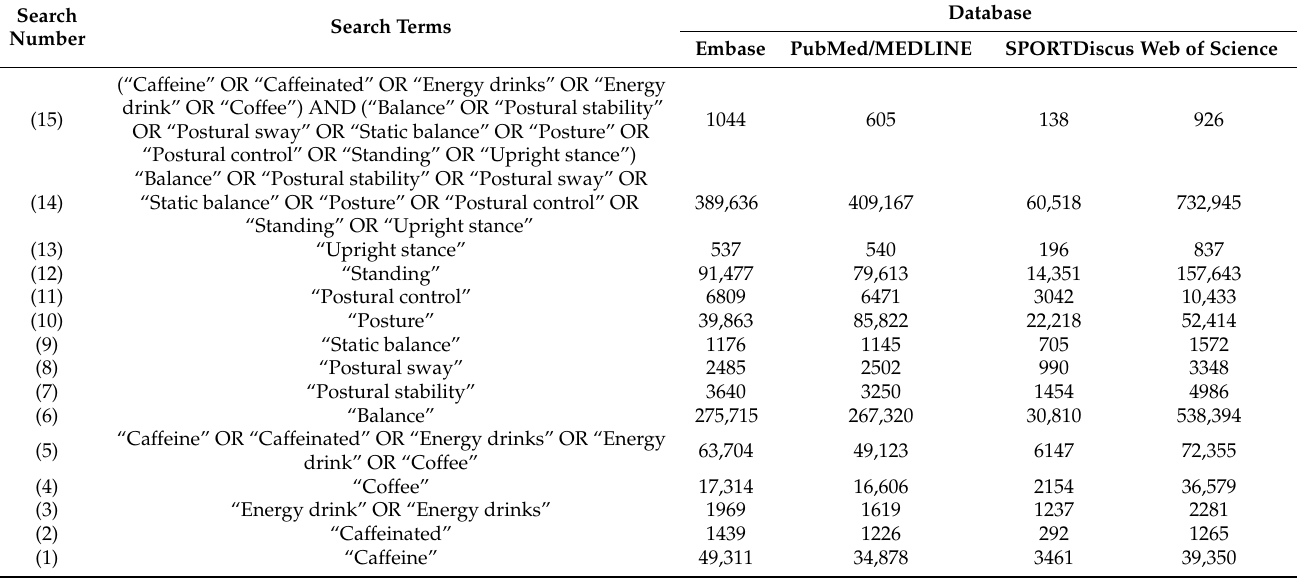
Table 2. Search strategy development